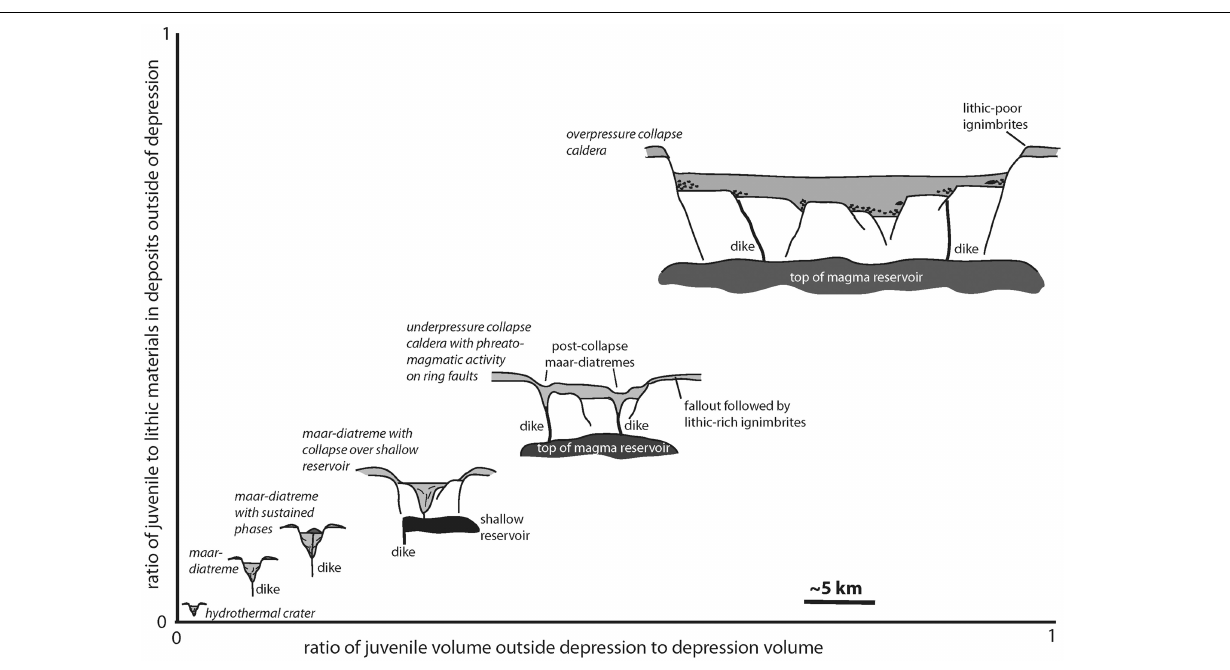
FIGURE 1 | Qualitative illustration of the spectrum of negative volcanic landforms produced by explosive eruptions, in terms of amount of juvenile material deposited outside the depression relative to lithic content and depression volume. Hydrothermal (phreatic) explosion craters are included in the diagram as extreme examples with no juvenile material, although strictly speaking they are not volcanic depressions even though they are commonly associated with